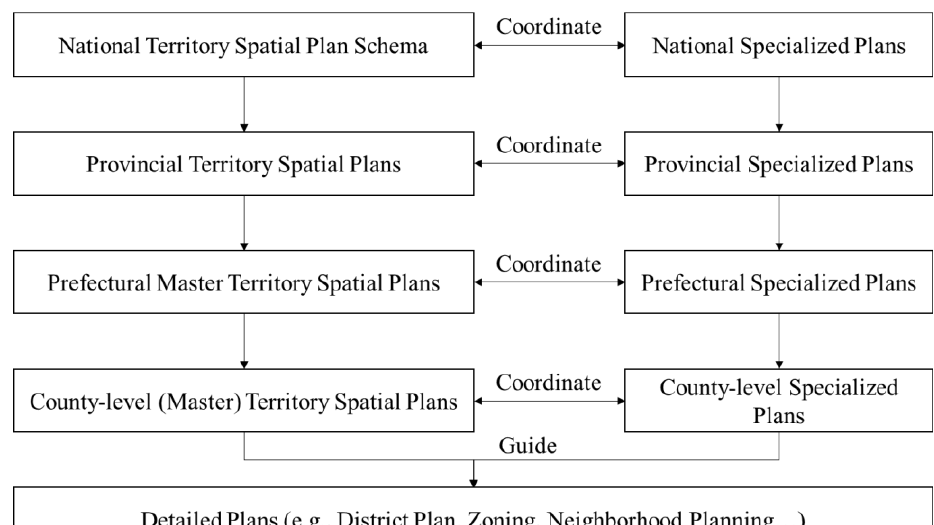
Figure 4. Territory spatial planning